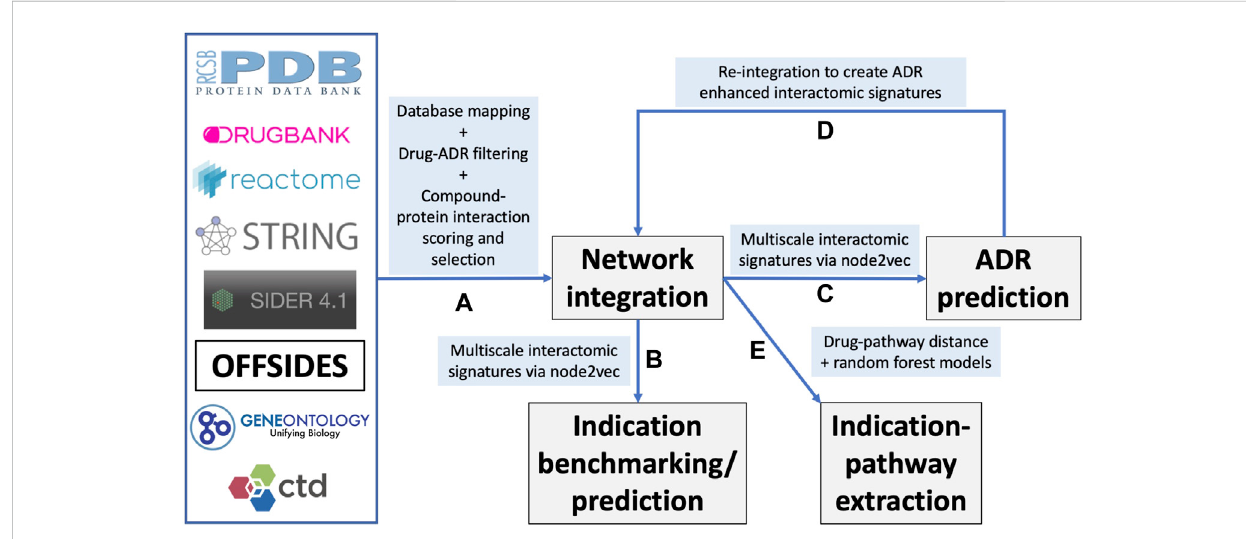
FIGURE 1 Overview of the CANDO multiscale interactomic signature pipeline and analyses (A) Multiple biomedical databases were integrated into a uni fi ed network architecture after matching the identi fi ers in these databases to drugs/compounds, proteins, and indications that were already present in the CANDO v2 platform. These databases included DrugBank, theProtein Data Bank (PDB), UniProt, Reactome, STRING, the Gene Ontology, OFFSIDES, and the Comprehensive Toxicogenomics Database. Prior to integration, ADR associations from the OFFSIDES database were fi ltered to eliminate redundancy withtheindication mappingobtained fromtheComparativeToxicogenomics Database.Compound-proteininteractionswerescored using our bioanalytical docking (BANDOCK) protocol. A normalization scheme was also devised to supplement the network with additional interactions (section 4.2). These and other associations between the entities in the heterogeneous databases were used to create an integrated network (B) A graph feature embedding algorithm, node2vec, was used to create multiscale interactomic signatures from multiple networks. These feature vectors or multiscalesignatureswerethenbenchmarkedasbefore(section4.3)toassesshowwelltheyrelateddrugsinthecontextoftheindicationsforwhichthey are approved, as well as used to generate novel drug candidates for various indications (Section 4.7) (C) The multiscale interactomicsignatures were also used to predict ADR associations for all compounds (D) These novel ADRs were re-integrated into the network and the resulting multiscale interactomic signatures werebenchmarked as in (B)(E) Finally,thedistanceofagivendrug nodeto eachpathway nodeserved asfeaturesfor inputinto randomforest machine learning models to identify those that are important for predicting drug-indication associations. Coupled with the results of the indication benchmarking, our fi ndings demonstrate that these network-based pipelines are superior to traditional CANDO pipelines for assessing similarity of drug behavior in biological